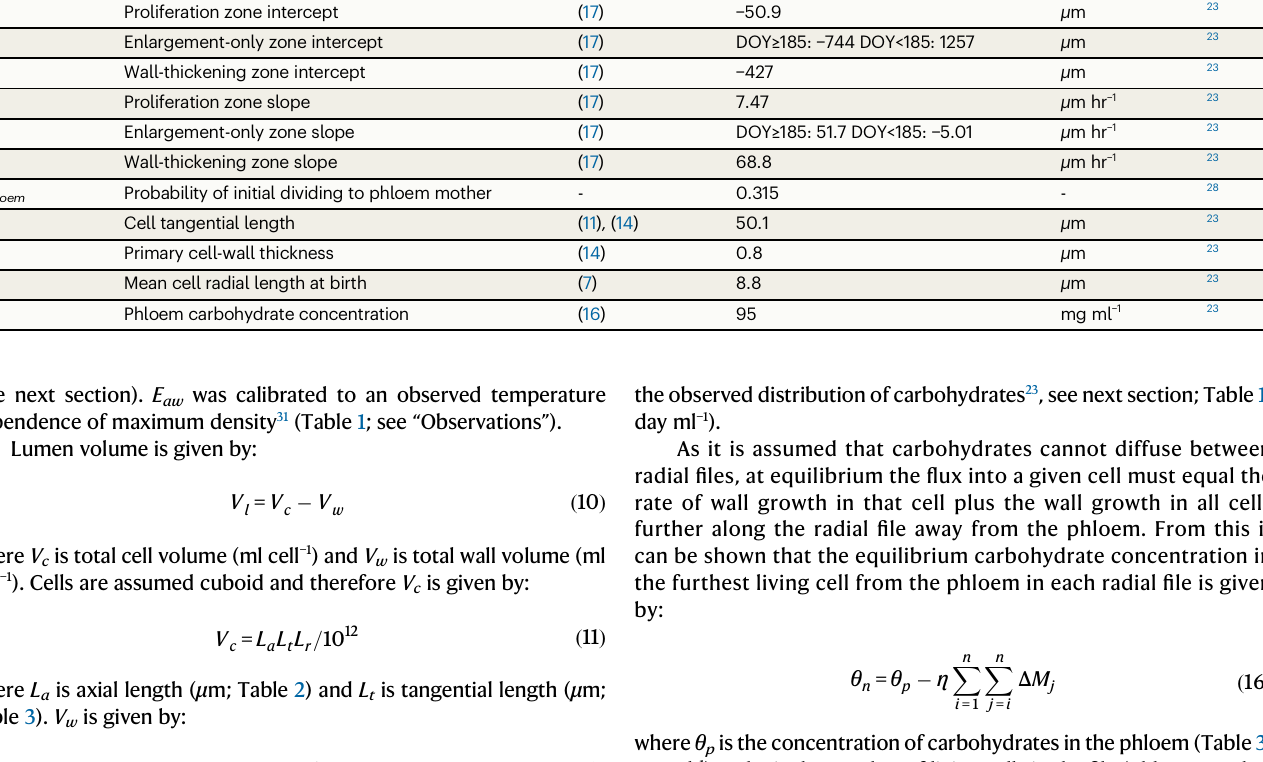
Table 3 | Parameters used in the model that are calculated from observations